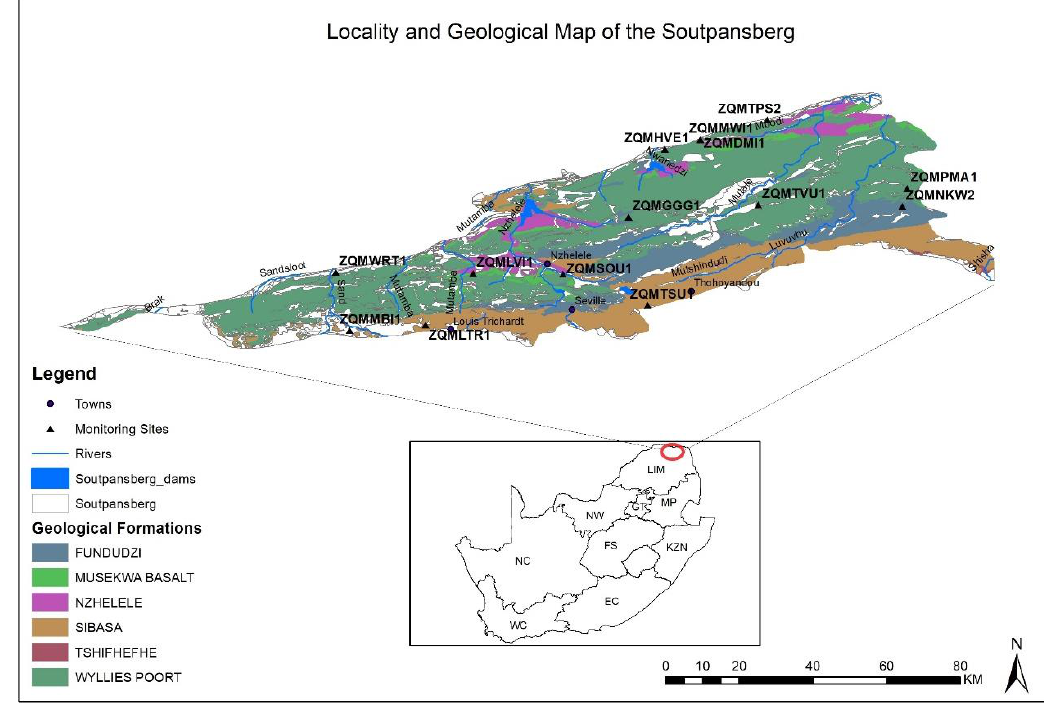
Figure 1. Locality and geological settings of the Soutpansberg region.